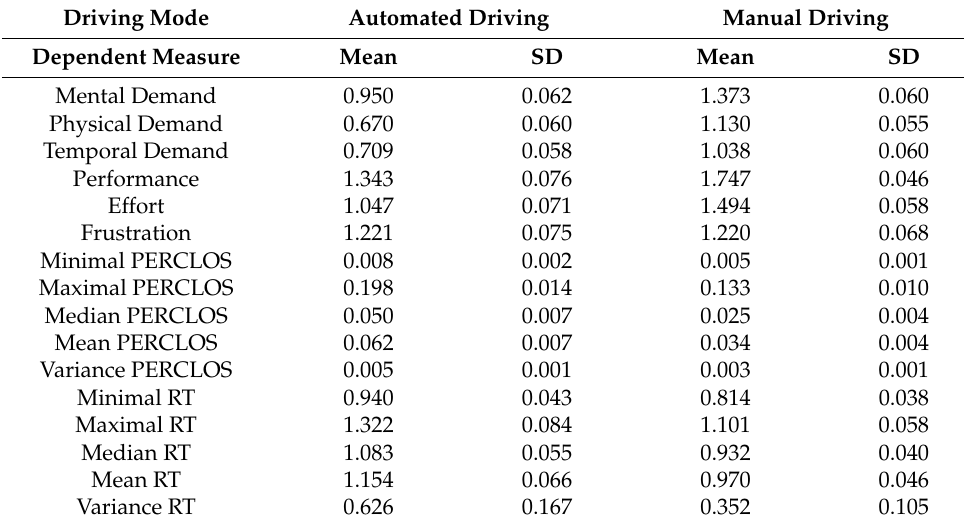
Table 2. Workload, PERCLOS, and reaction time (RT) in automated and manual